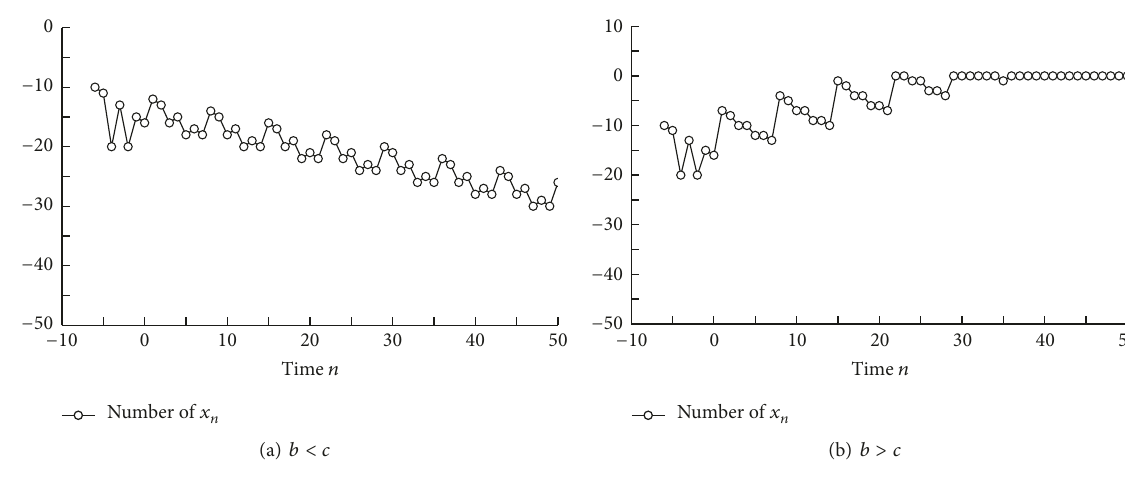
Figure 1: Numerical illustration of a solution behaviour ( 𝜔 = 6